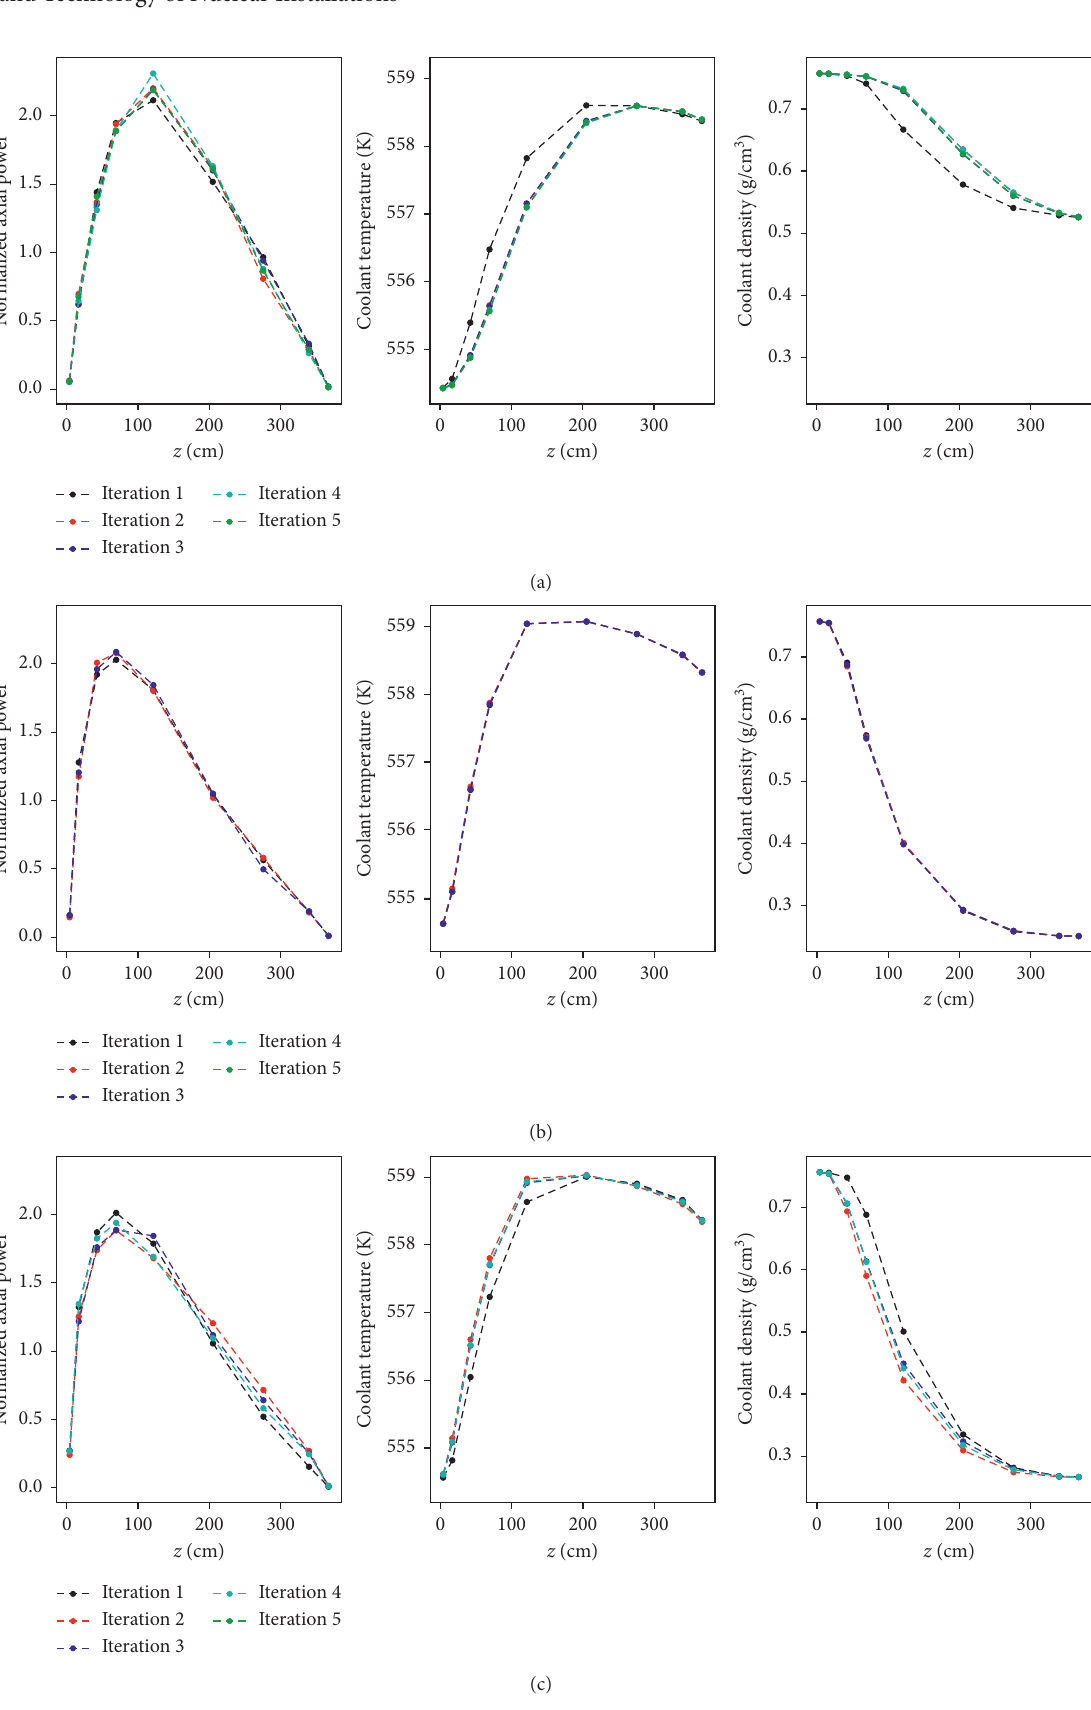
Figure 5: Convergence of neutronics and thermal-hydraulic coupling parameters based on the 2F2DN23/SF98 for three selected burnup steps. (a) BU step 1. (b) BU step 6. (c) BU step